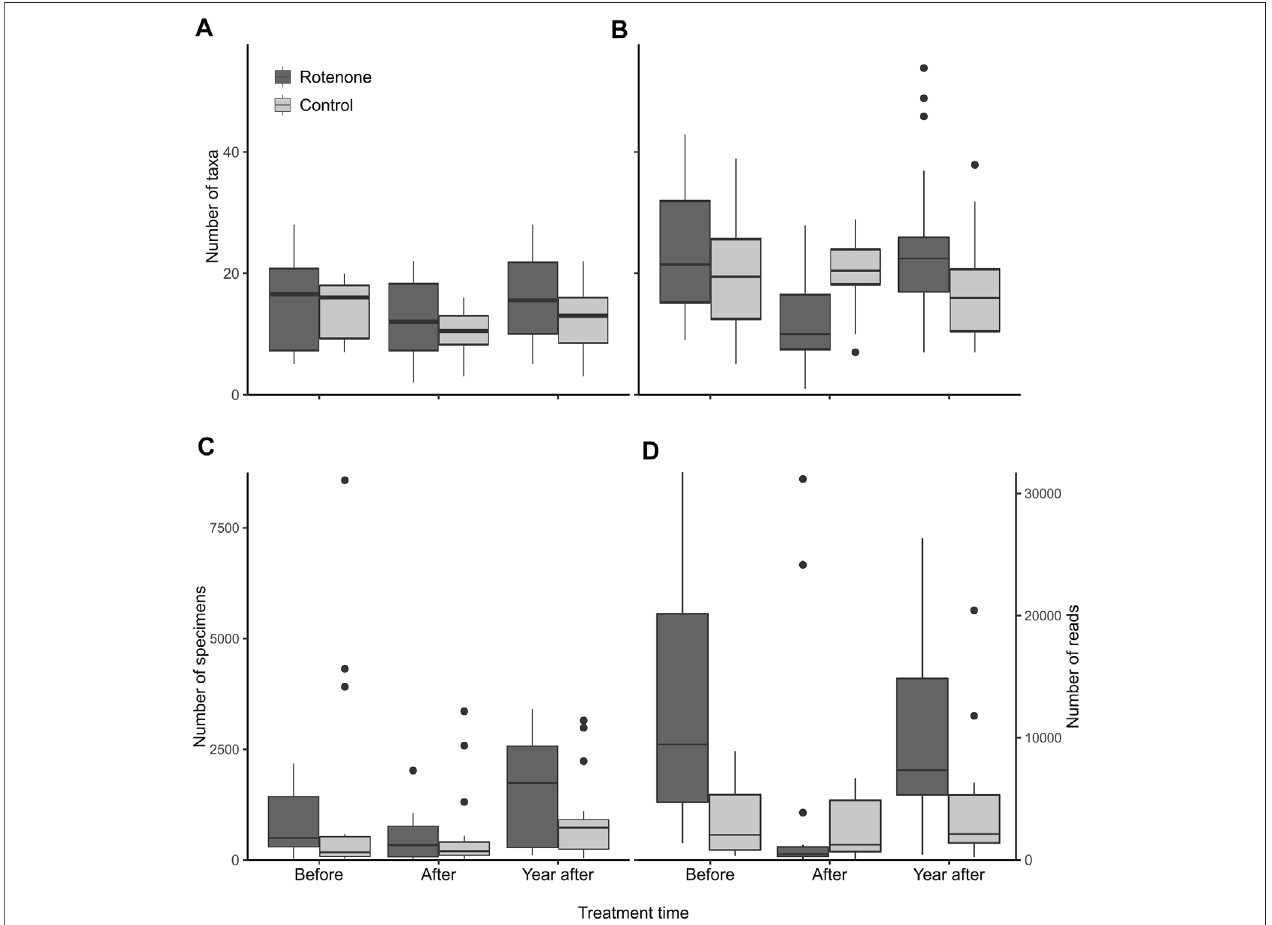
FIGURE3| Thenumberoftaxaintherotenonetreatedandcontrollakesamplesbasedonmorphologicalidenti fi cation (A) ,identi fi cationusingDNAmetabarcoding ofpeDNA (B) ,thenumberofspecimensbasedonmorphologicalidenti fi cation (C) andthenumberofreadsusingDNAmetabarcodingofpeDNA (D) .Thesamplesizefor each category is 18. The horizontal line in each box represents the median, the boxes depict the 1st to the 3rd quartile and the blind end of the whiskers represent the maximum and minimum values, except outliers which are marked with dots.